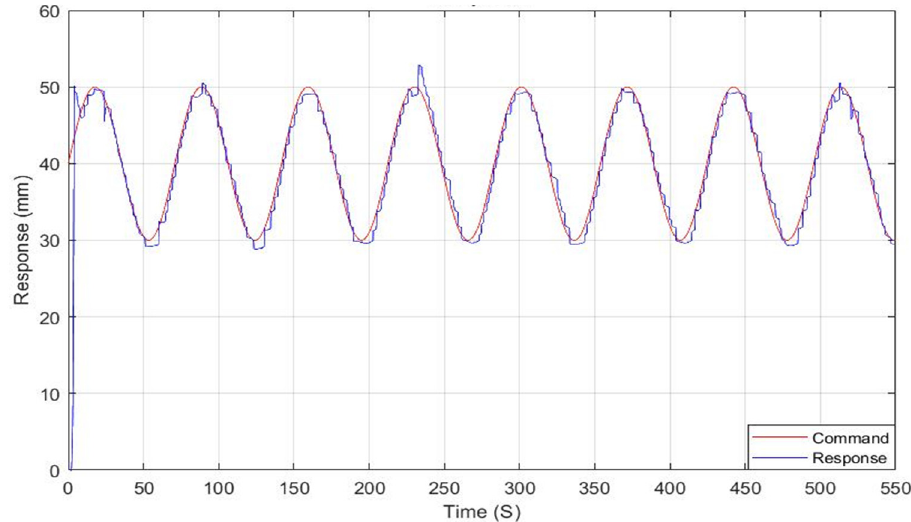
Figure 16. A closed-loop displacement control of the sine command signal.